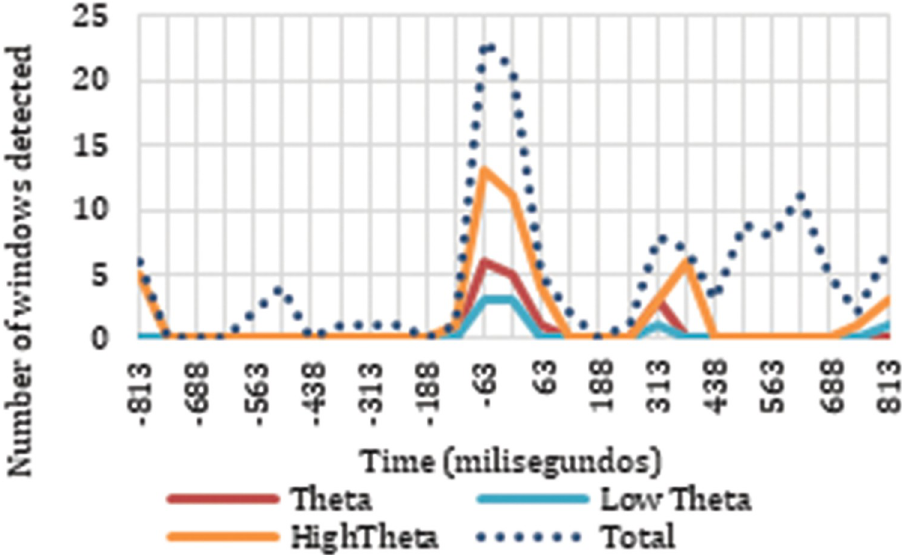
Fig 5. Distribution of sliding windows detected as triggered by the cut in theta